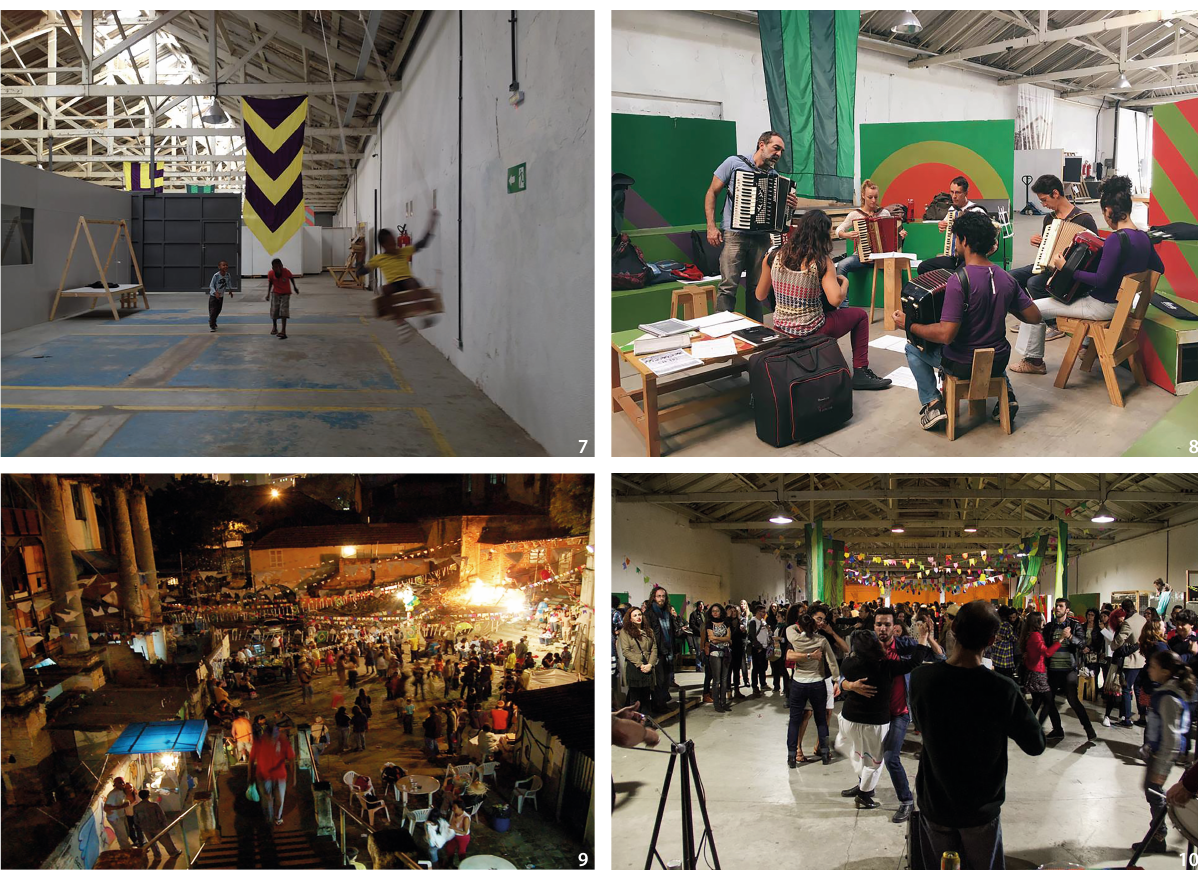
Figure 7 Spontaneous uses of the shed, playground (Source: Instituto Pedra, 2015). Figure 8 Spontaneous uses of the shed, accordion classe (Source: Instituto Pedra, 2015). Figure 9 June Seasonal Party at Vila Itororó. A traditional event used to occur at Vila, before the removal of the tenants (Source: Lígia Pinheiro/Mosaico, 2006). Figure 10 June Seasonal Party at Vila Itororó. Party held during the restoration (Source: Instituto Pedra,